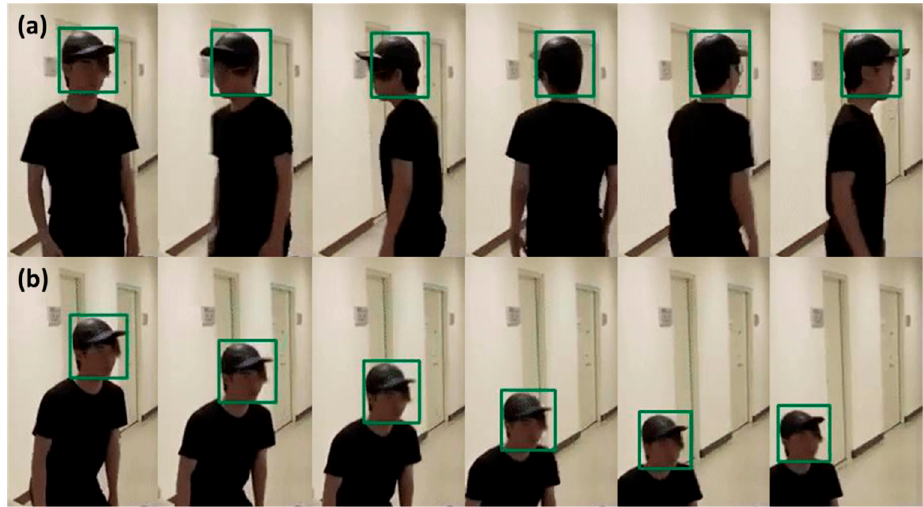
Figure 4. The image series shows the performance of the synergy of cascade face detection and CSRT tracker. The image in ( a ) exhibits the tracking results when the subject stands with their back to the camera. The image in ( b ) shows the tracking results when the subject is in a sudden fall situation.